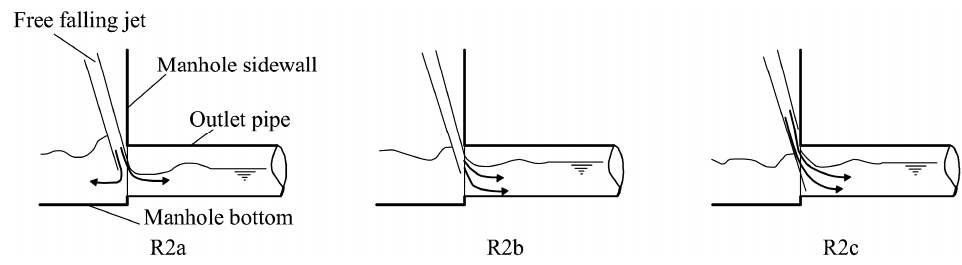
Figure 2. Regime R2 with subregimes.